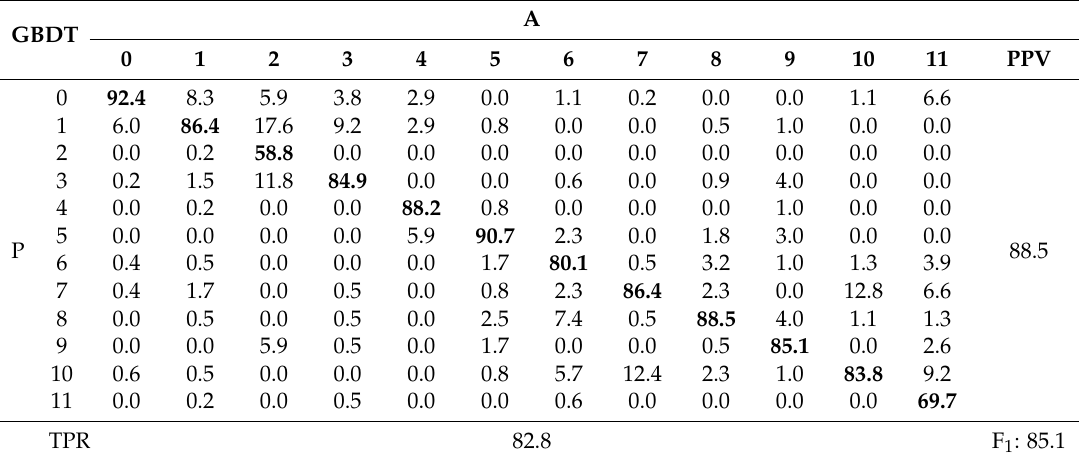
Table 14. The Confusion Matrix of the GBDT Classifier.